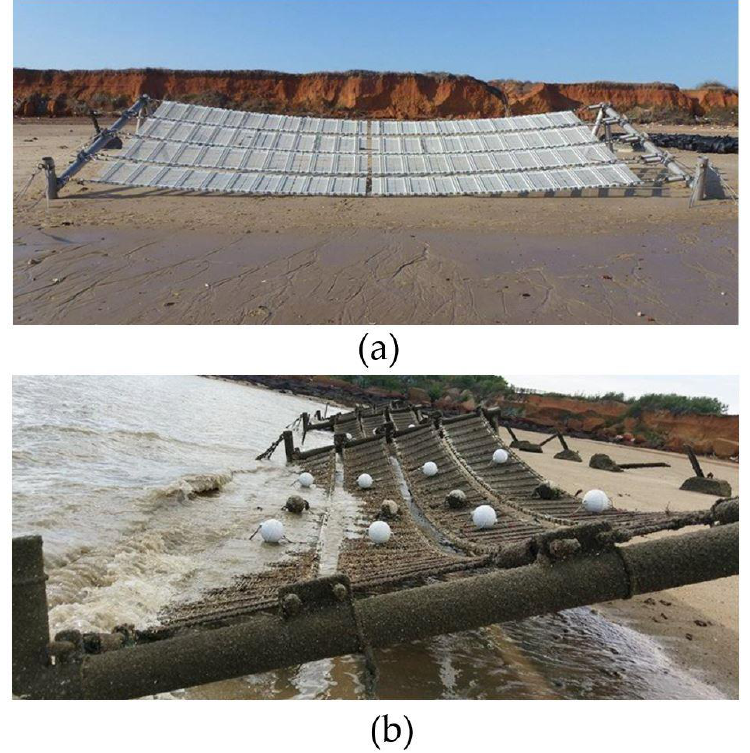
Figure 4. The derosion lattice when ( a ) installed completely and ( b ) being used in Taiwan [2].